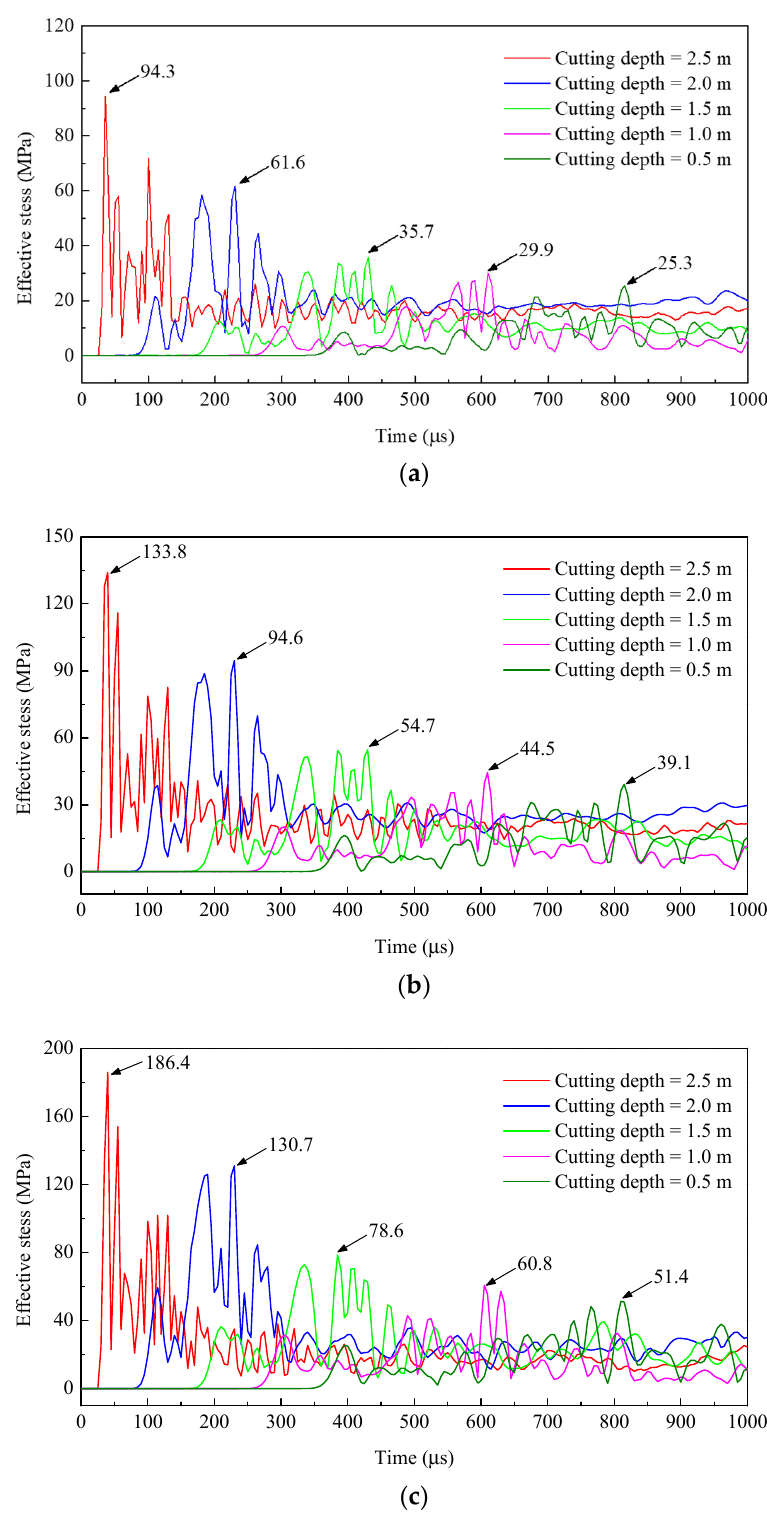
Figure 8. Stress–time curves of measurement points. ( a ) Φ 32 mm holes matching Φ 27 mm cartridges. ( b ) Φ 42 mm holes matching Φ 35 mm cartridges. ( c ) Φ 50 mm holes matching Φ 45 mm